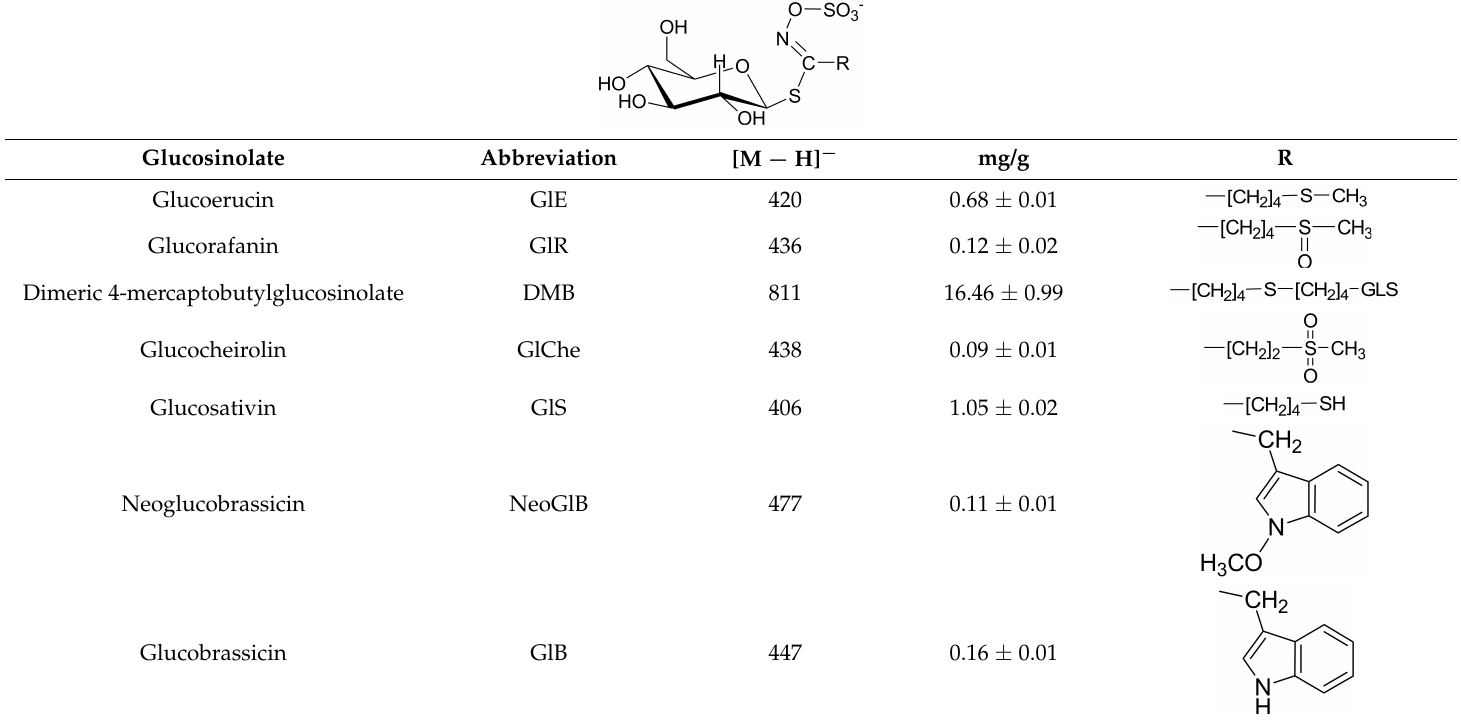
Table 1. Glucosinolates identified by LC/ESI-MS n in freeze-dried rocket